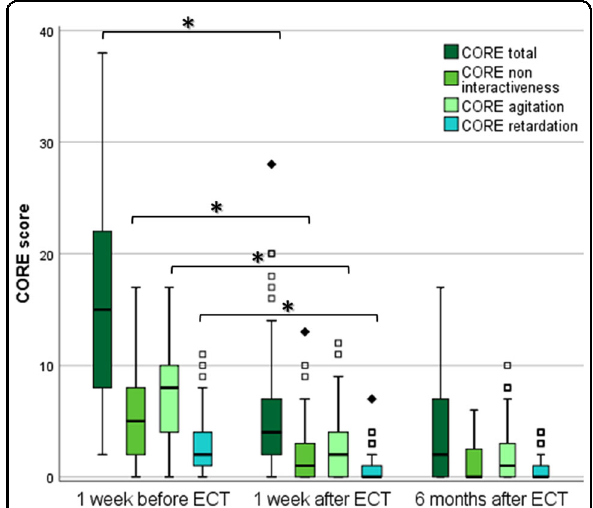
Fig. 3 CORE total and CORE subscale scores before and after ECT. ECT electroconvulsive therapy. * p < 0.05, Bonferroni – Holm correction applied. Black squares = outliers (>|2x SD|), diamonds = extreme outliers (>|3x